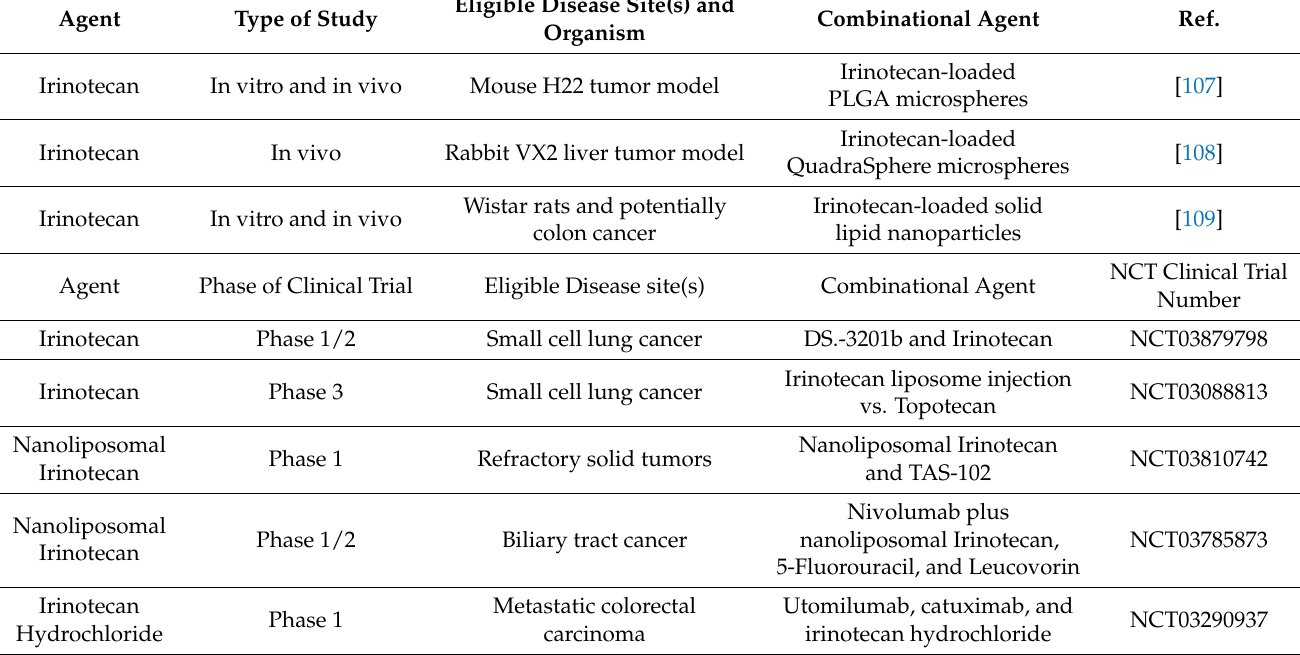
Table 2. Preclinical and clinical studies with irinotecan and its modification in monotherapy and combination